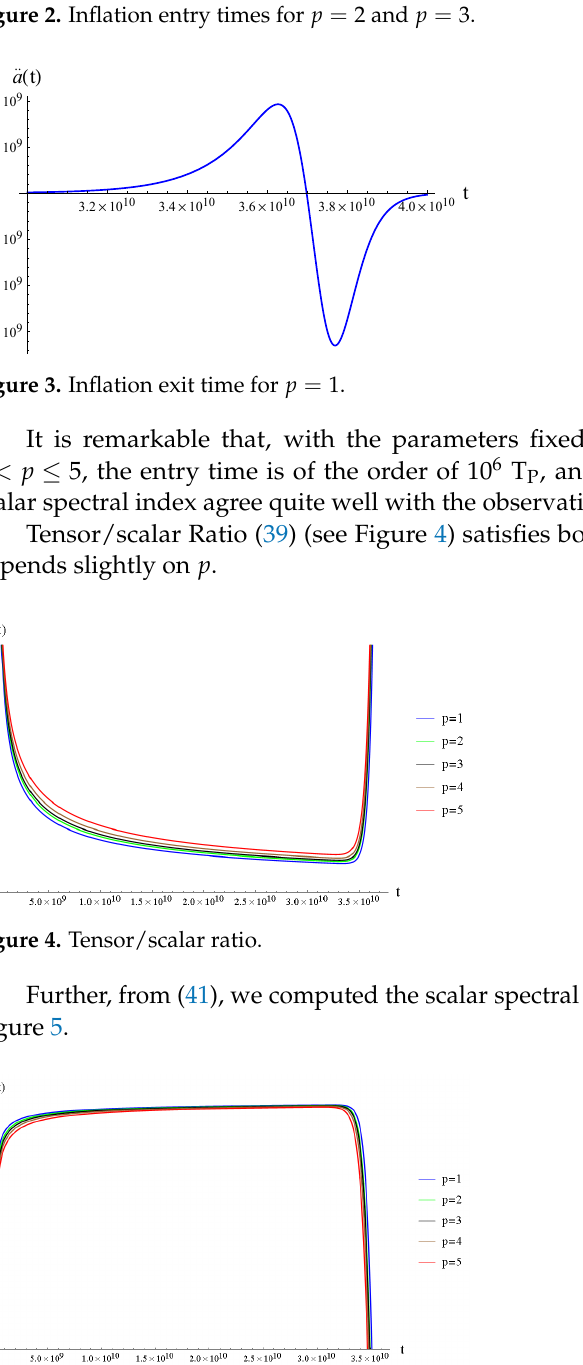
Figure 5. Scalar spectral